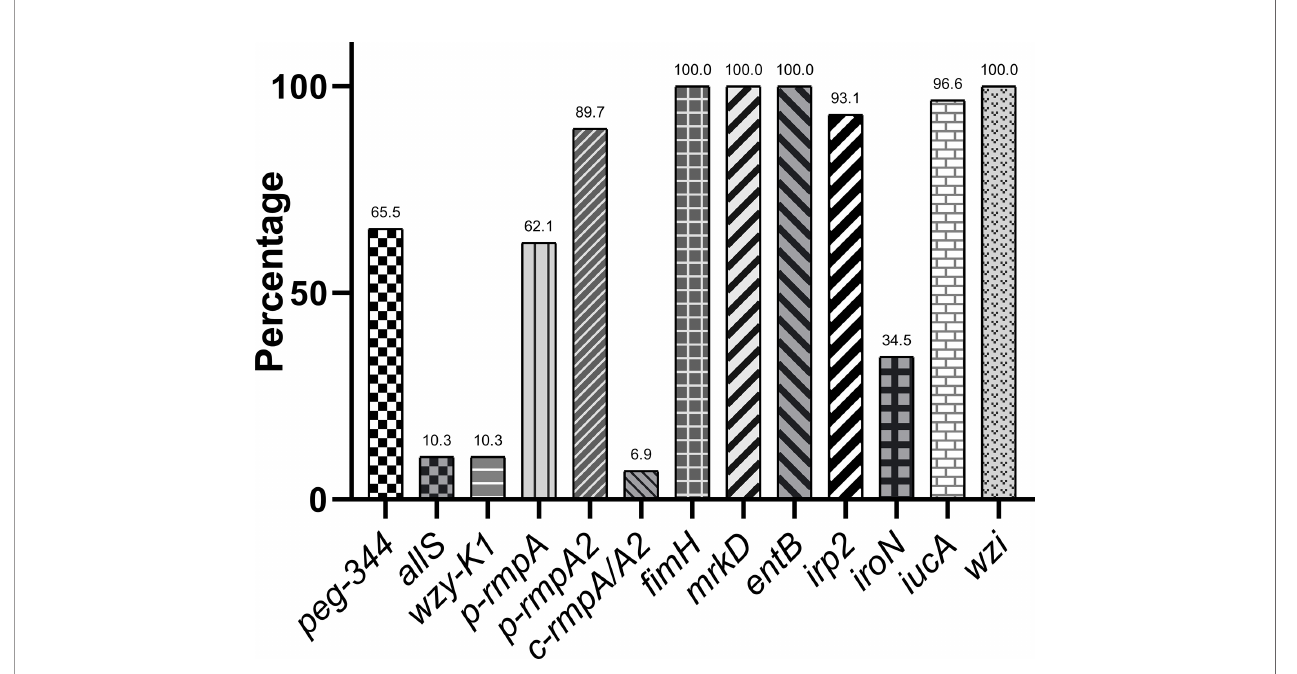
FIGURE 4 | Distributions of virulence genes in Hv- bla KPC (+)-KP.